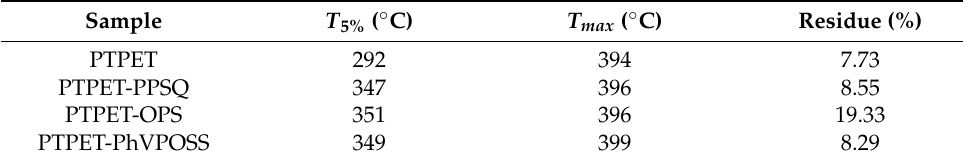
Figure 10. TG ( A ) and DTG ( B ) curves of PTPET elastomer and composites. Table 2. TG data of PTPET elastomer and